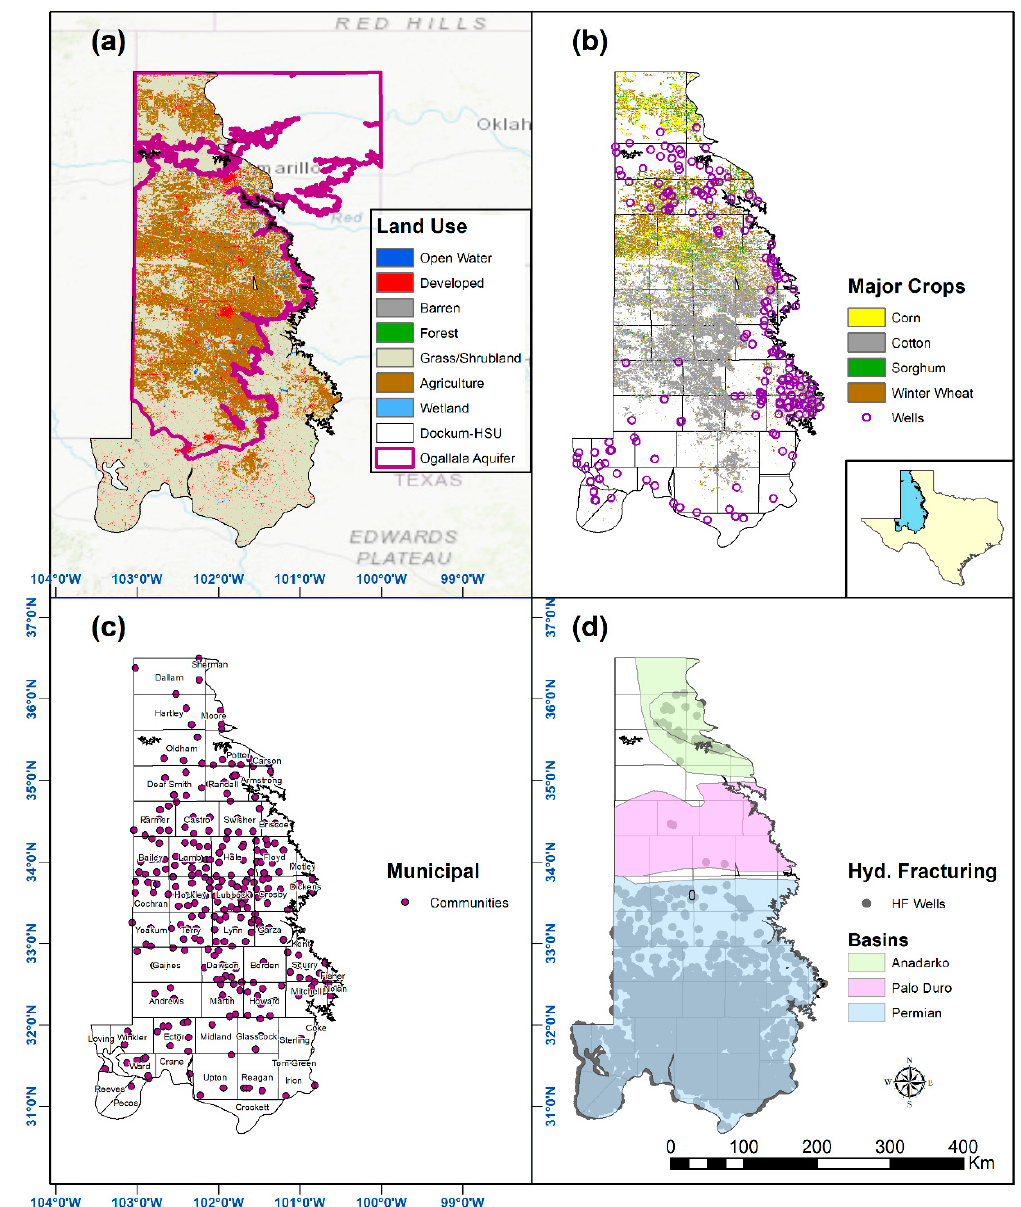
Figure 1. Characteristics of the Southern High Plains (SHP) Region of Texas. ( a ) land use and major groundwater units; ( b ) locations of major crops and monitoring wells; ( c ) major population centers; and ( d ) oil and gas basins and hydraulic fracturing locations.